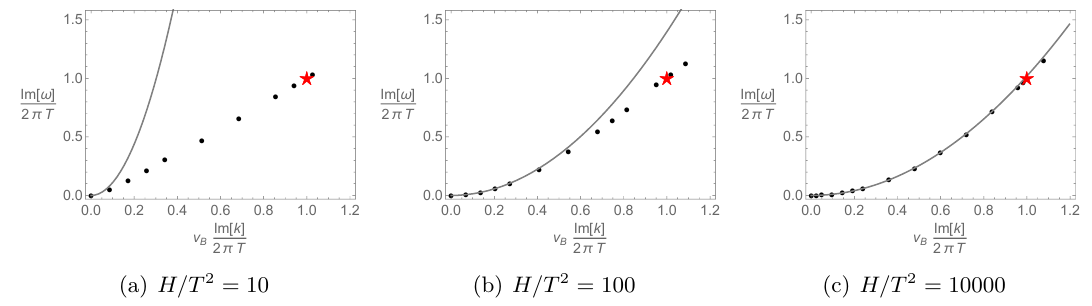
Figure 8 . Pole-skipping vs magneto-hydrodynamics with various H . In all figures, black dots are numerically computed quasi-normal modes, the red star corresponds to the pole-skipping point (2.14), and the gray solid line is the diffusive mode